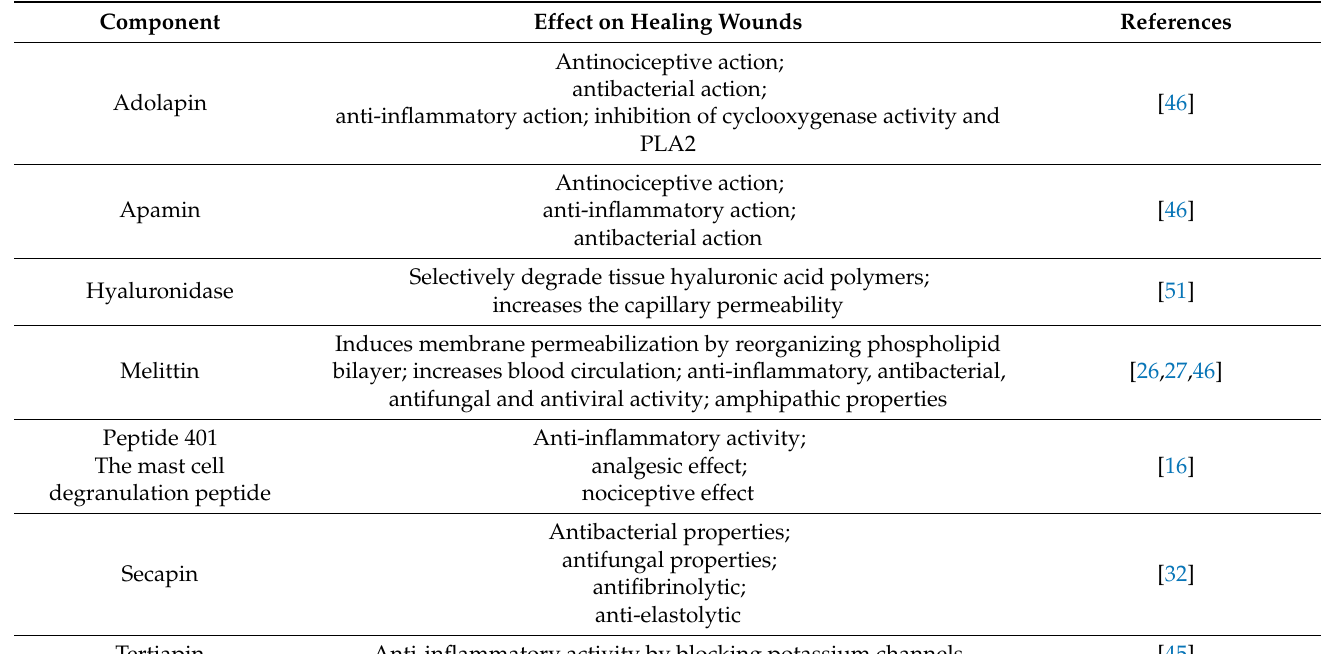
Table 1. Effect of compounds of bee venom on healing wounds.